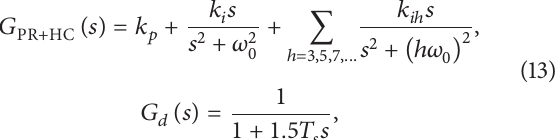
Figure 8: 𝑃𝑄 diagram and PVpower-voltage curve(black bold line) in different operation modes: (1) MPPT mode and (2) grid fault